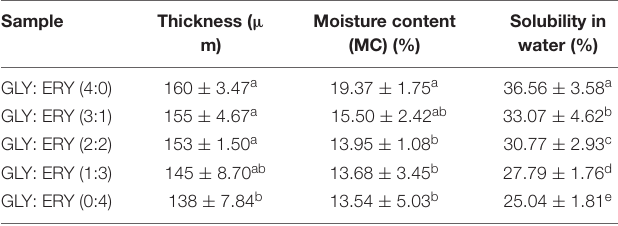
TABLE 1 | Functional properties of the corn starch-based films supplemented with GLY and ERY (4:0, 3:1, 2:2, 1:3, 0:4). Sample